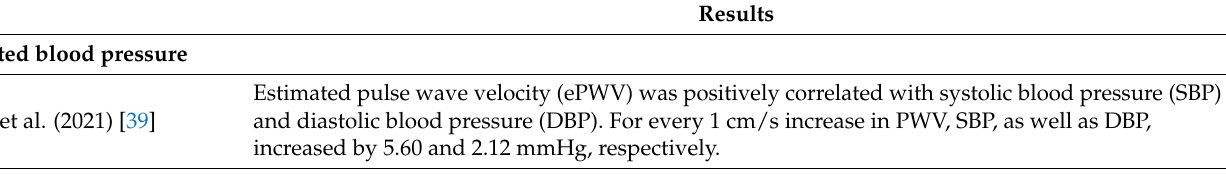
Table 2. Characteristics of some selected included studies on the impact of metabolic syndrome components on arterial